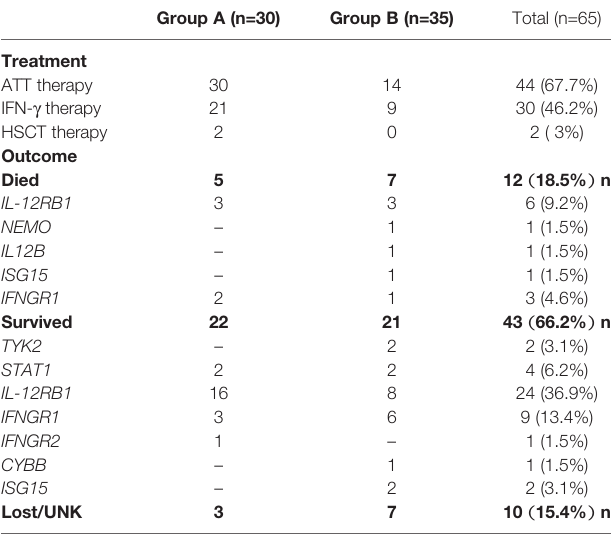
TABLE 3 | Treatment and prognosis of the 65 MSMD patients reported in China. Group A (n=30) Group B